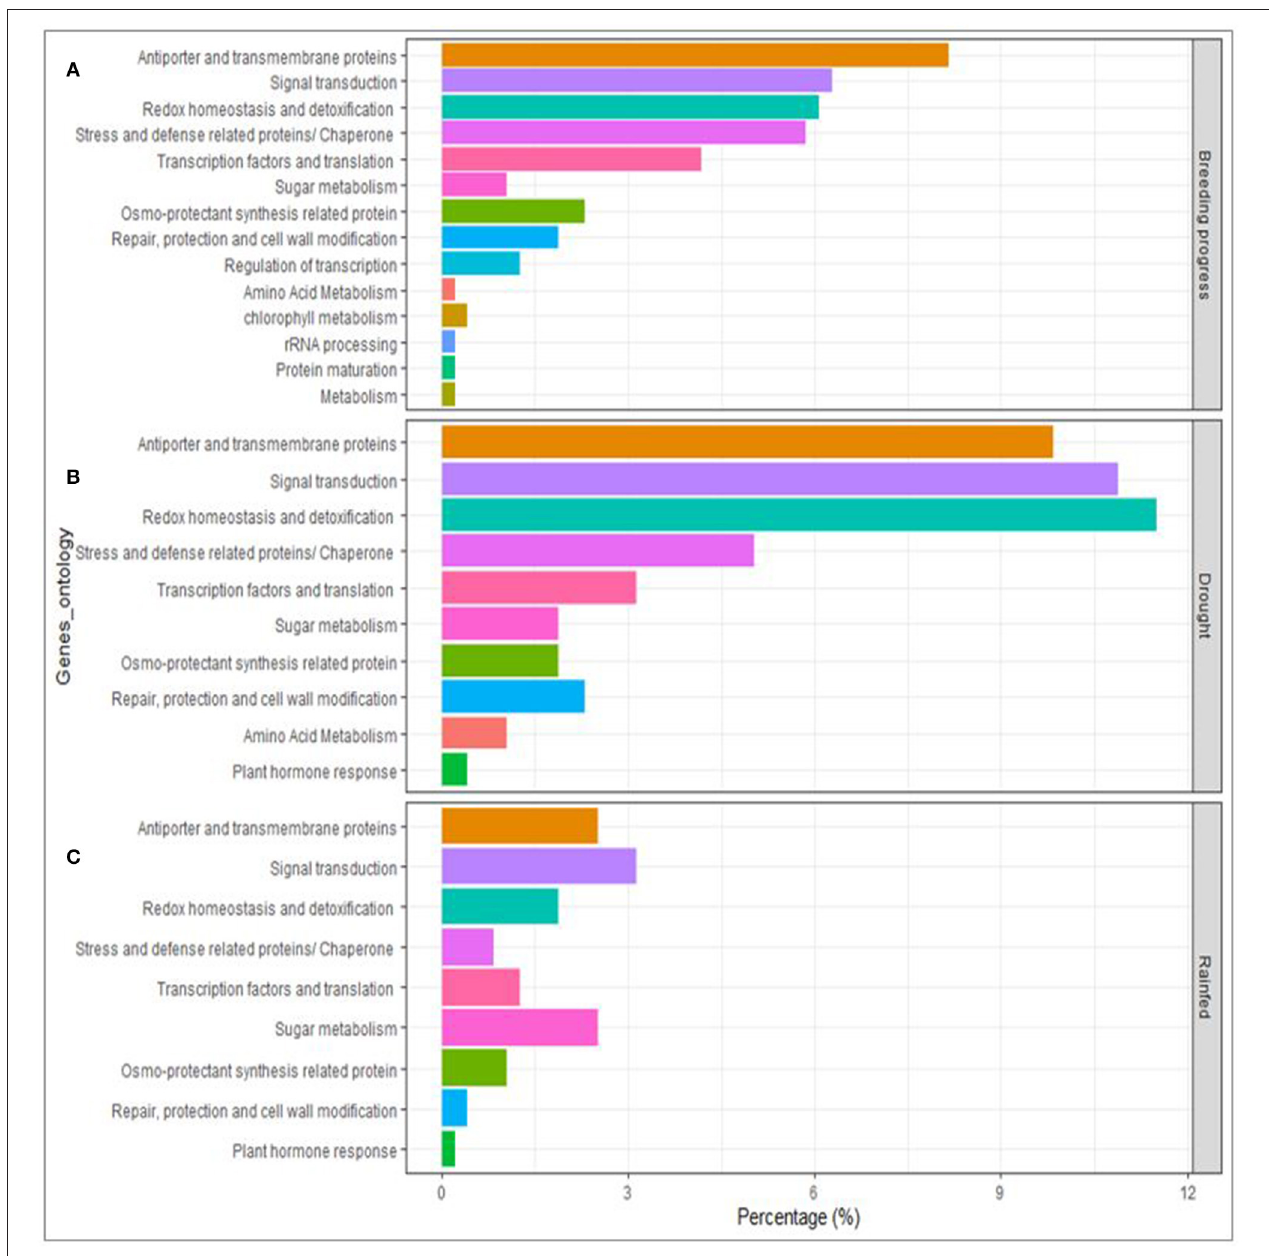
FIGURE 7 | Genes annotation and ontological classifications of the associated DNA sequences underlying breeding progress and the traits of interest under drought and rainfed conditions using